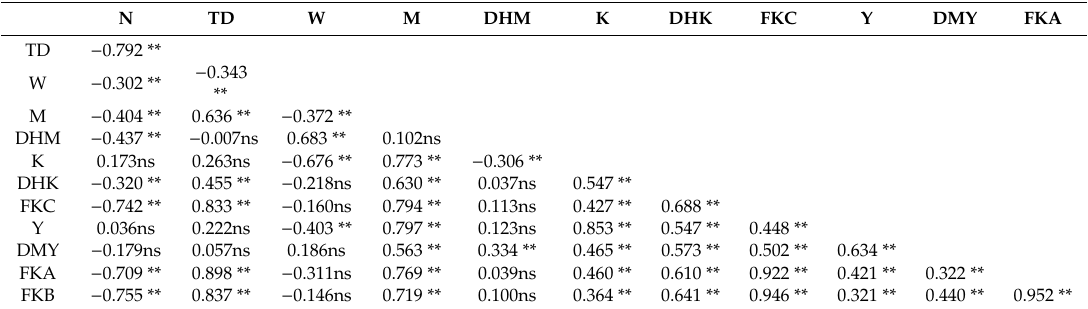
Table 3. Correlation values for major compounds and groups of varieties (N, TD, W) (PLS-R analysis).